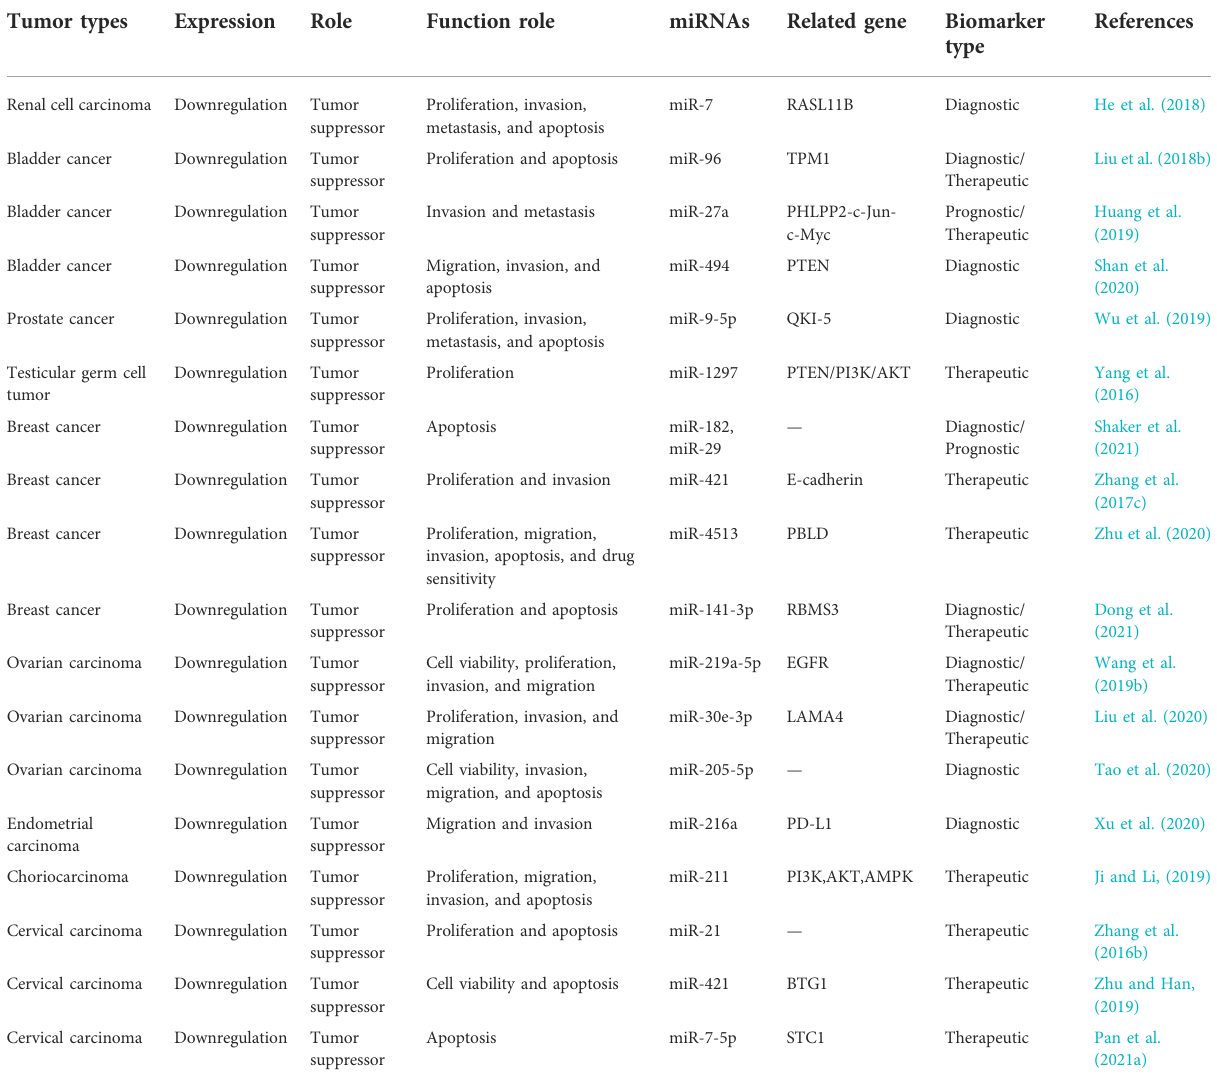
TABLE 3 Characterization of MEG3 function in genitourinary system